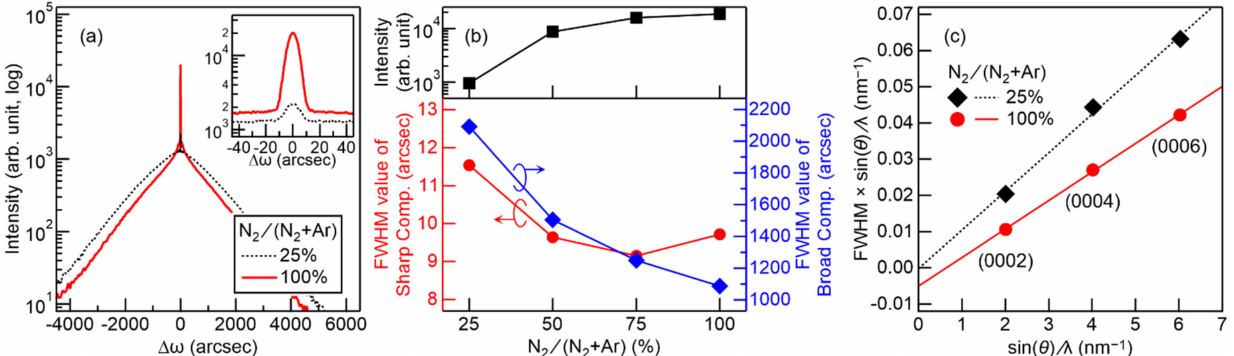
Figure 2. X-ray diffraction reciprocal space map (XRD-RSM) images of ( a , d ) AlN(0002); ( b , e ) AlN(0004); and ( c , f ) AlN(0006) diffractions of as-sputtered AlN films using N 2 /(N 2 + Ar): ( a – c ) 25% and ( d – f ) 100%.